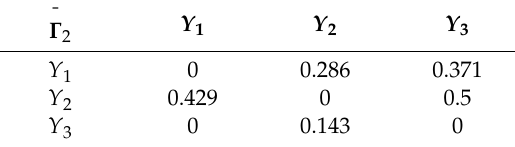
Table 14. The normalized rejoice matrix Γ 2